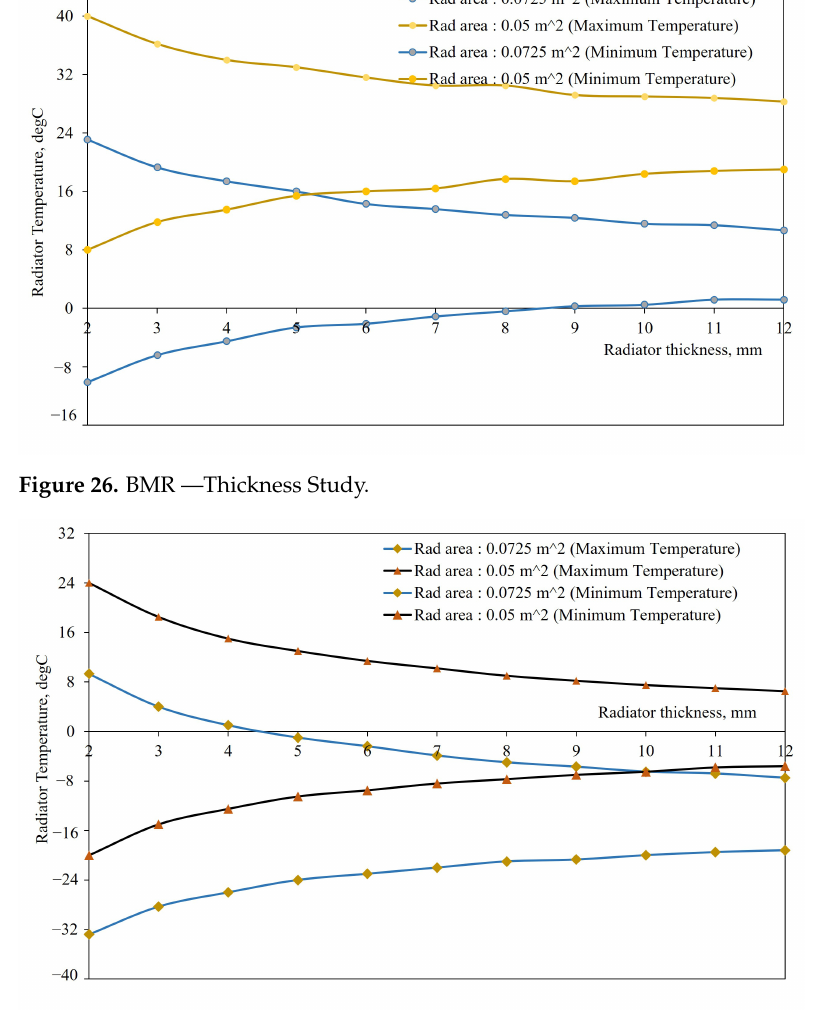
Figure 27. DR—Temperature variation with radiator thickness.